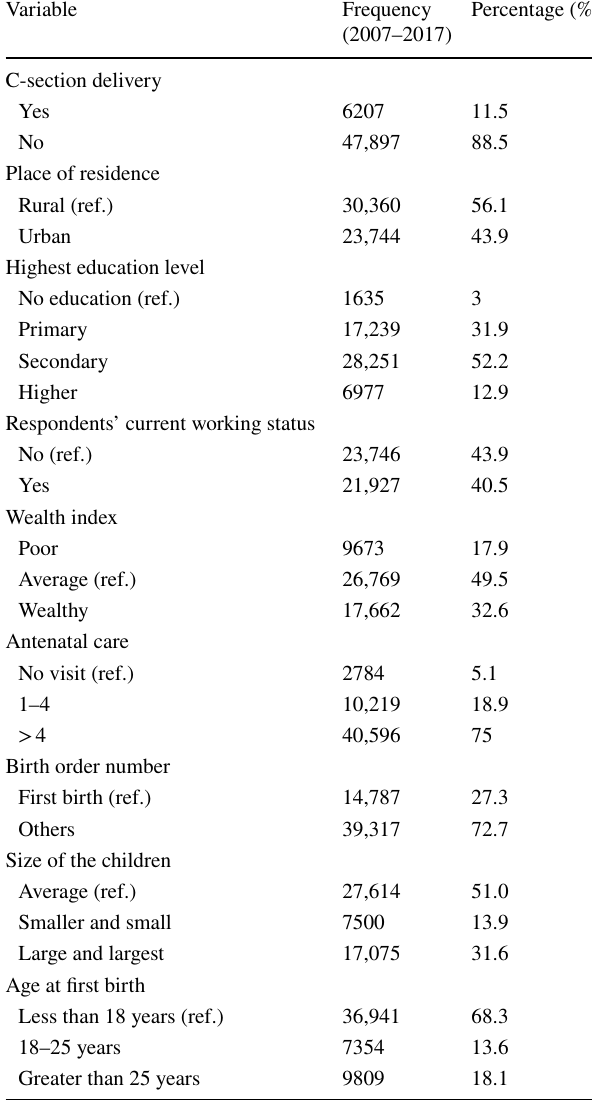
Table 3 Baseline characteristics of selected factors from a combined data set from three Indonesia Demographic and Health Surveys,